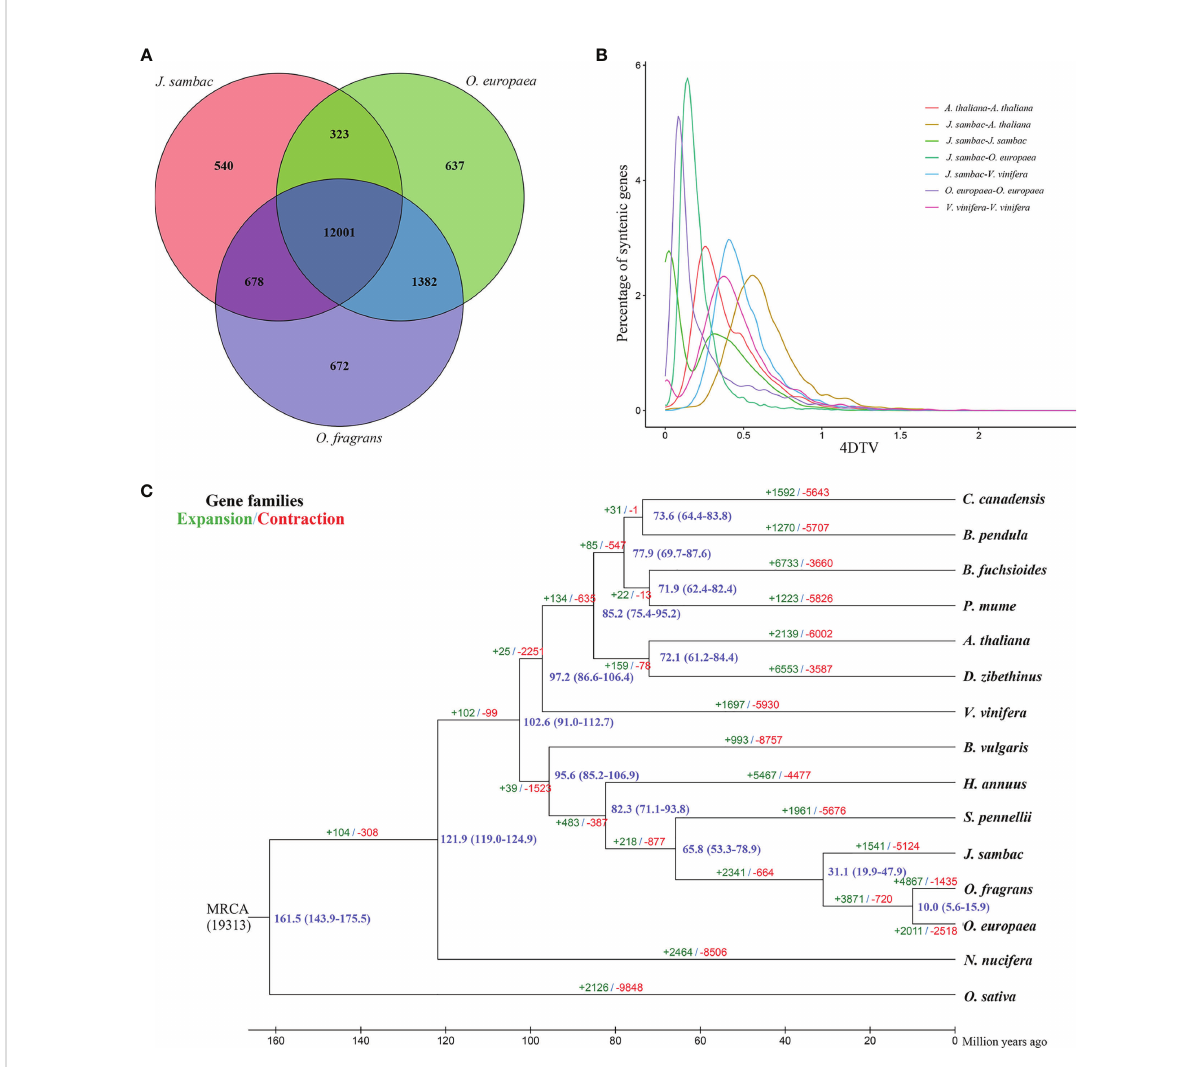
FIGURE 1 Evolution and comparative analysis of the J . sambac cultivar JSDB genome. (A) Venn diagram of J . sambac , O. europaea and O. fragrans . Each number in the diagram was the gene family number within a group. (B) Fourfold degenerate distributions for J . sambac , O. europaea , A . thaliana , and V. vinifera . (C) Phylogenomics relationships, divergence times and gene family expansion and contraction of 15 plant species. The blue numbers on the nodes were divergence time to present (in Mya). The green and red numbers above or under each branch denoted the expanded and contracted gene families after the diversi fi cation from the most recent common ancestor (MRCA),